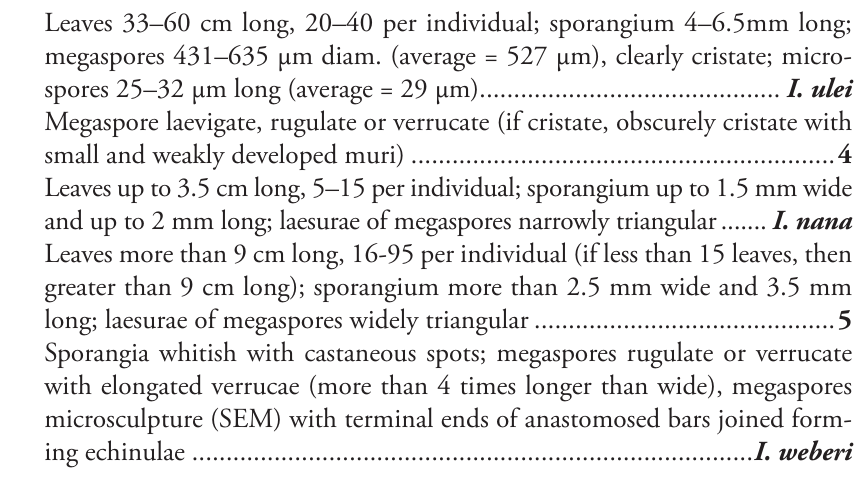
and up to 2 mm long; laesurae of megaspores narrowly triangular ....... I. nana Leaves more than 9 cm long, 16-95 per individual (if less than 15 leaves, then greater than 9 cm long); sporangium more than 2.5 mm wide and 3.5 mm 5 Sporangia whitish with castaneous spots; megaspores rugulate or verrucate with elongated verrucae (more than 4 times longer than wide), megaspores microsculpture (SEM) with terminal ends of anastomosed bars joined